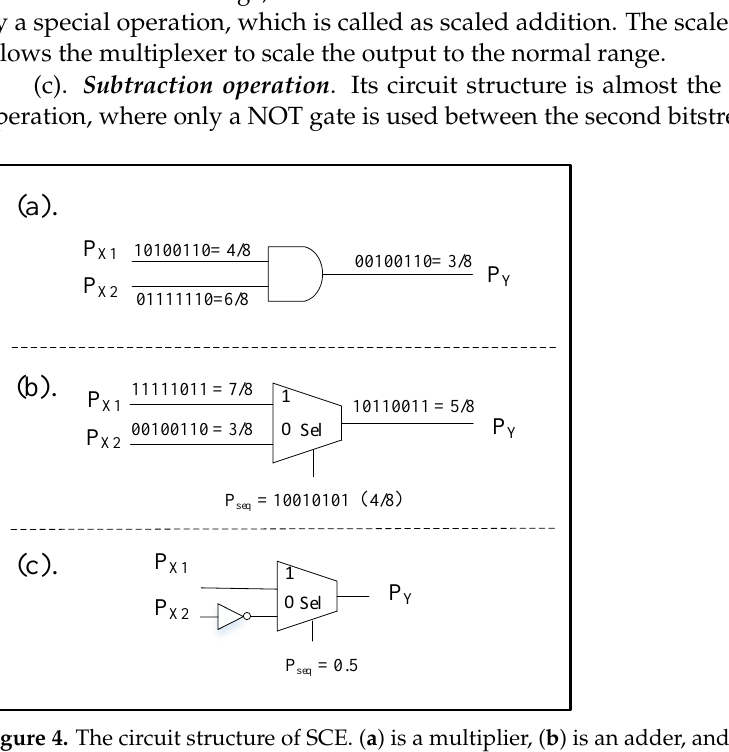
Figure 4. The circuit structure of SCE. ( a ) is a multiplier, ( b ) is an adder, and ( c ) is a